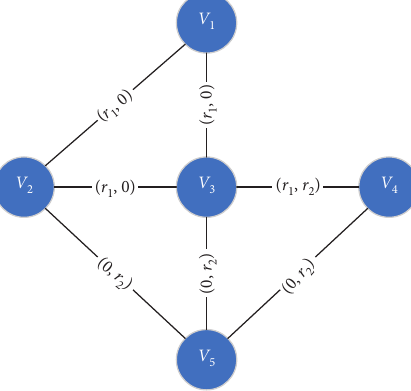
Figure 1: The structure of a typical MSCCN